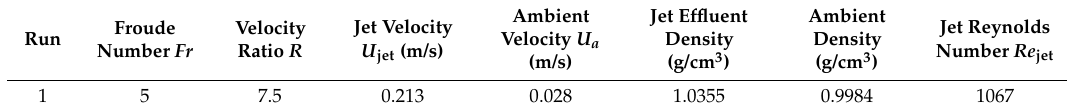
Figure 1. Schematic diagram of the flow configuration. Table 1. Simulation